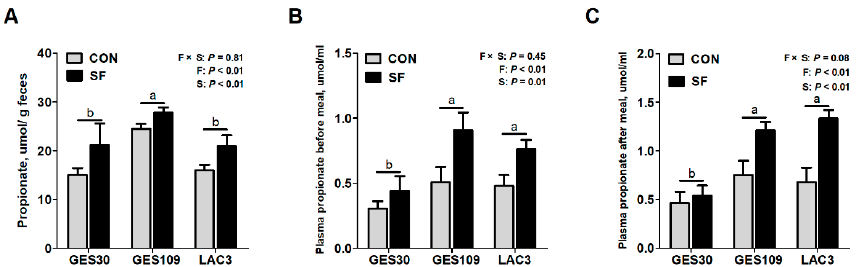
Figure 4. E ff ects of soluble fiber during gestation on propionate production of sows. ( A ) Fecal propionate. ( B ) Plasma propionate before meal. ( C ) Plasma propionate after meal. Data are expressed as mean ± SEM ( n = 8). When significant main e ff ects or interactive e ff ects were observed, the means were compared using the least significant di ff erence method with a p < 0.05 indicating significance. a-b, significant e ff ect of breeding stage ( p < 0.05; values with di ff erent lowercase letters are significantly di ff erent). GES109, day 109 of gestation; LAC3, day 3 of lactation. CON, control diet; SF, 2.0% soluble fiber combination